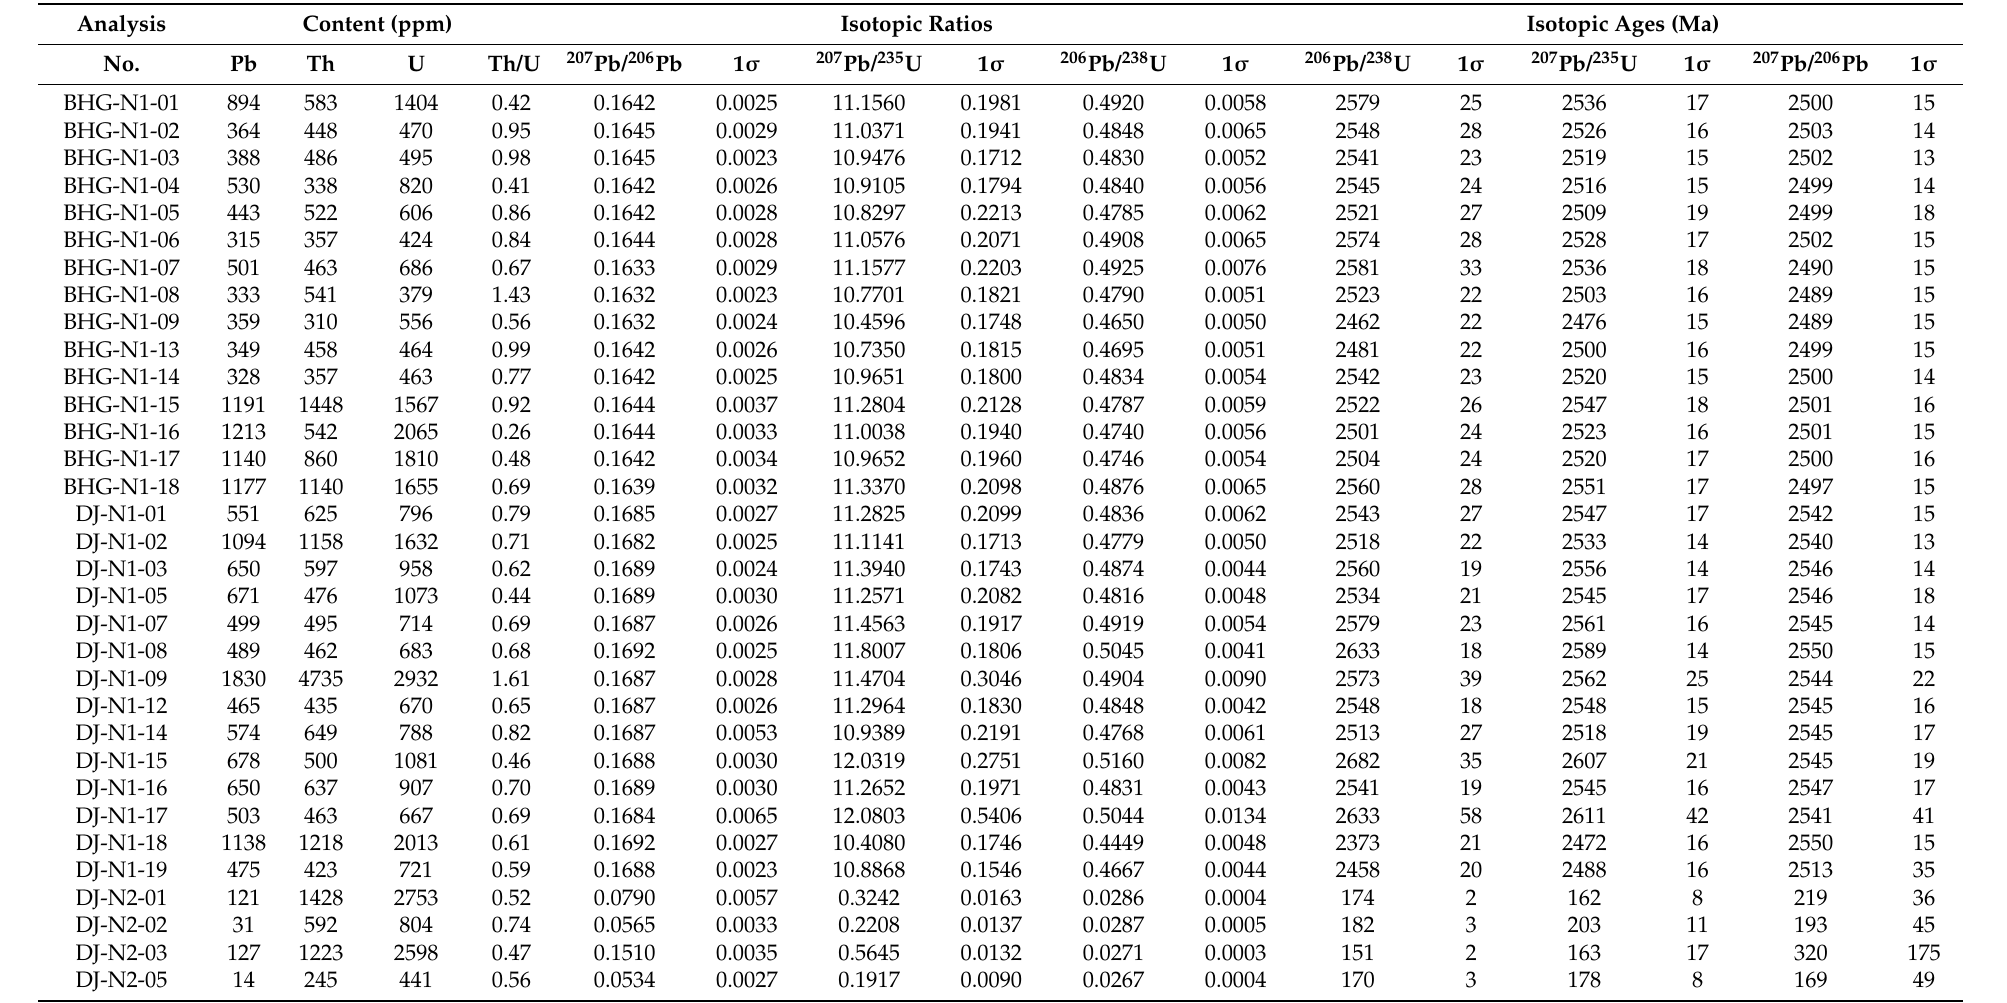
Table 3. Results of LA-ICPMS U–Pb dating for the single-grain zircon from the TTG gneisses and diorite samples in the Liuhe